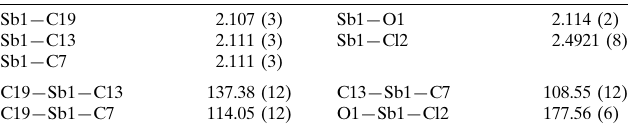
Selected geometric parameters (A˚ , (cid:2) ).